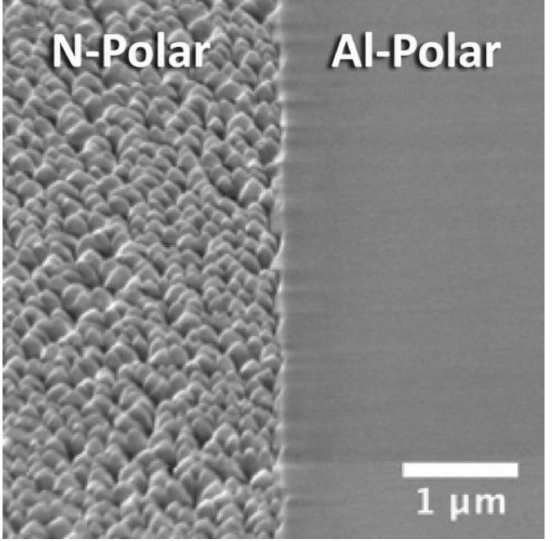
Figure 1. Morphology difference between N-polar and Al-polar AlN on the same wafer. Reprinted from [23], with the permission of AIP Publishing.